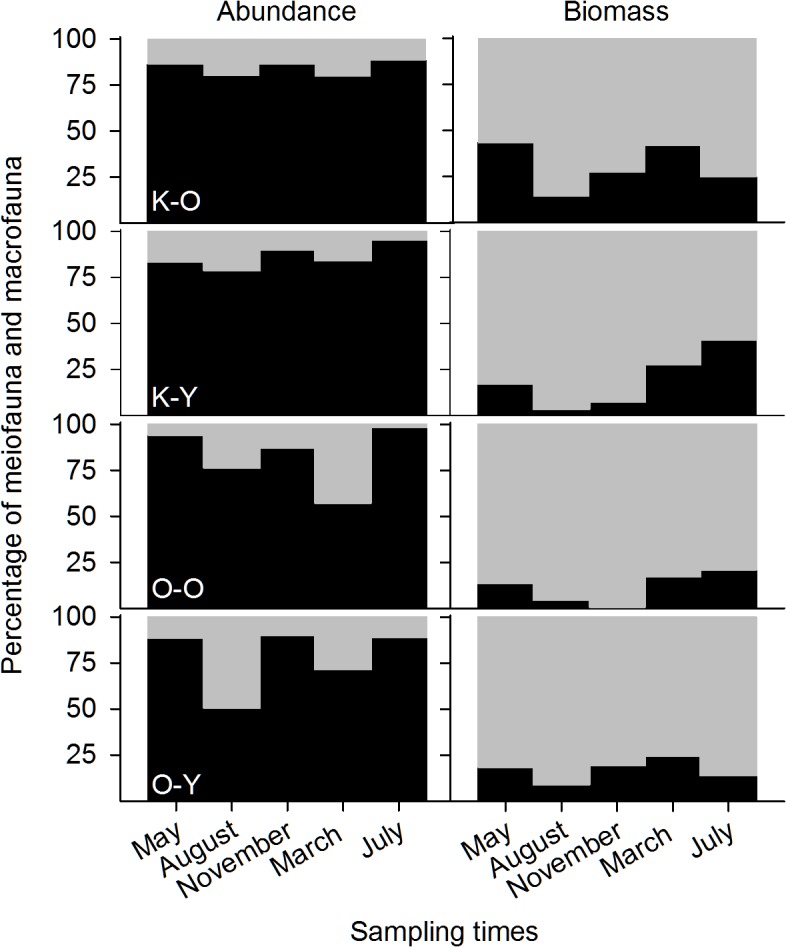
Mean percentages of meiofaunal (black areas) and macrofaunal (gray areas) abundances (left column) and biomasses (right column).Data are given for the four sampling sites, K-O (Kühnauerheide, old forest), K-Y (Kühnauerheide, young forest), O-O (Oranienbaumer Heide, old forest), and O-Y (Oranienbaumer Heide, young forest), at the five sampling times.